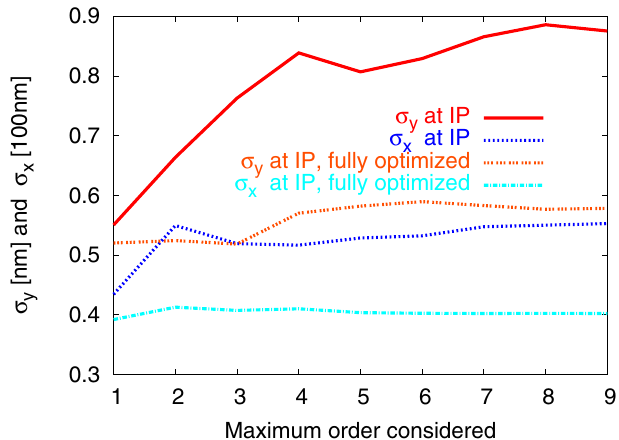
FIG. 6. (Color) Horizontal and vertical rms beam sizes at the CLIC IP for the nominal BDS and the one linearly and non- linearly optimized.